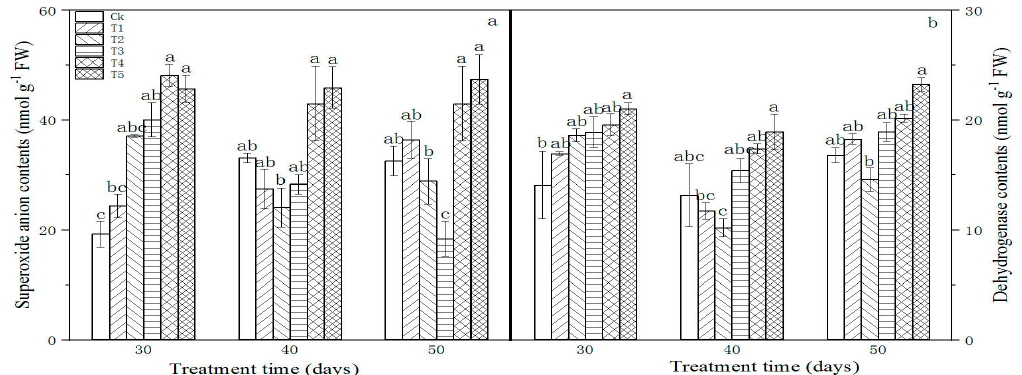
Figure 5. Superoxide anion ( a ) and hydrogen peroxide ( b ) contents of L. olgensis leaves treated with different concentrations of graphene. Values followed by the same letter for the same days are not significantly different at p < 0.05. Ck, T1, T2, T3, T4, and T5 represent 0, 25, 50, 100, 250, and 500 mg L -1 graphene treatments, respectively.